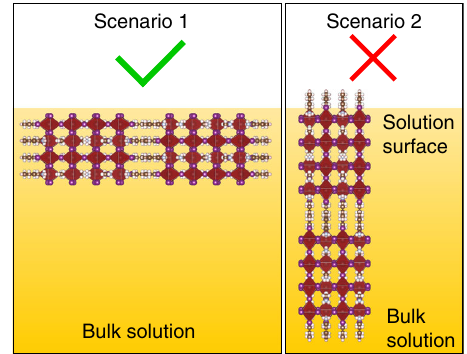
Fig. 4 Schematics of preferred orientation at liquid – air interface. The two possible nucleus orientations at the anisotropic precursor solution – air interface are shown in scenario 1 and scenario 2. The vertical orientation in crystallized crust con fi rmed by GIWAXS indicates that scenario 1 is